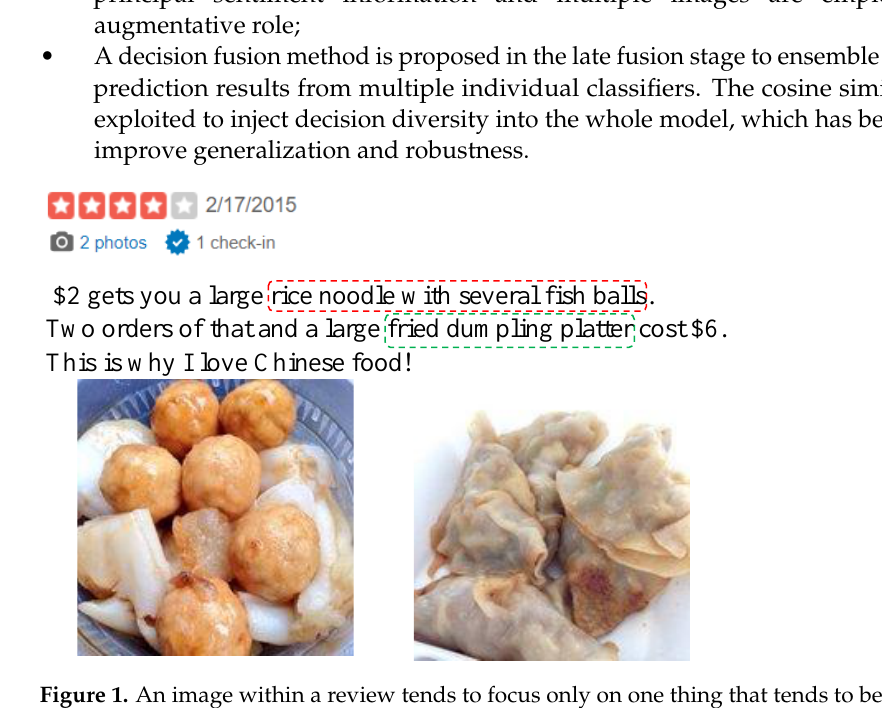
Figure 1. An image within a review tends to focus only on one thing that tends to be mentioned in the textual content, while the sentences within a review tend to involve several things and sentiment- bearing